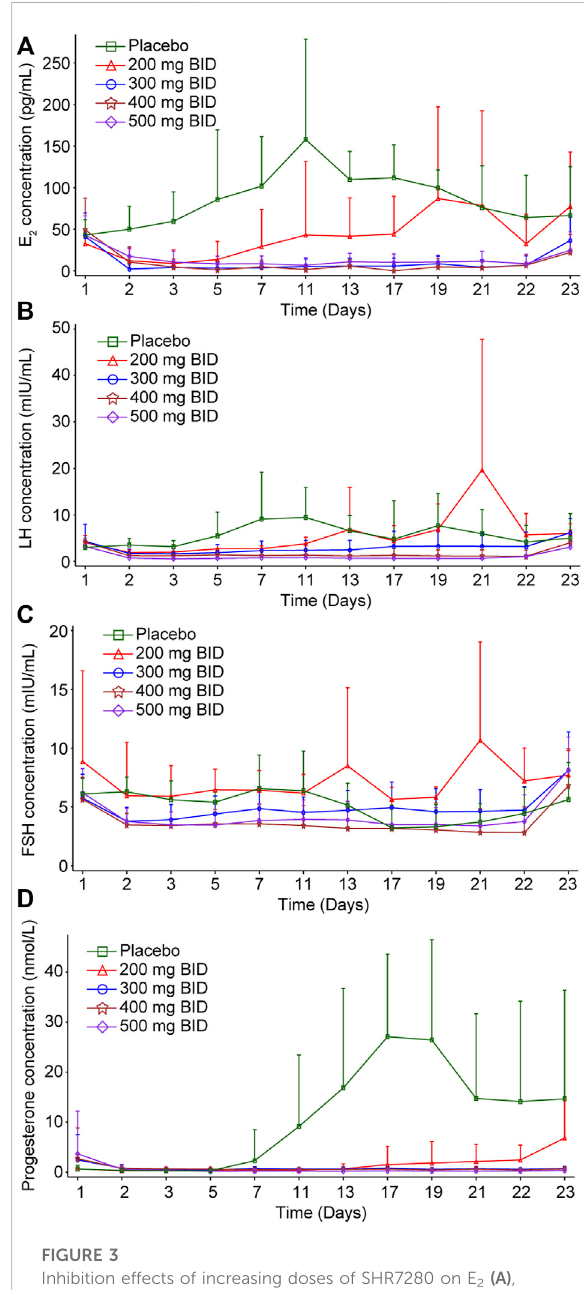
FIGURE 3 Inhibition effects of increasing doses of SHR7280 on E 2 (A) , LH (B) , FSH (C) , and progesterone (D)